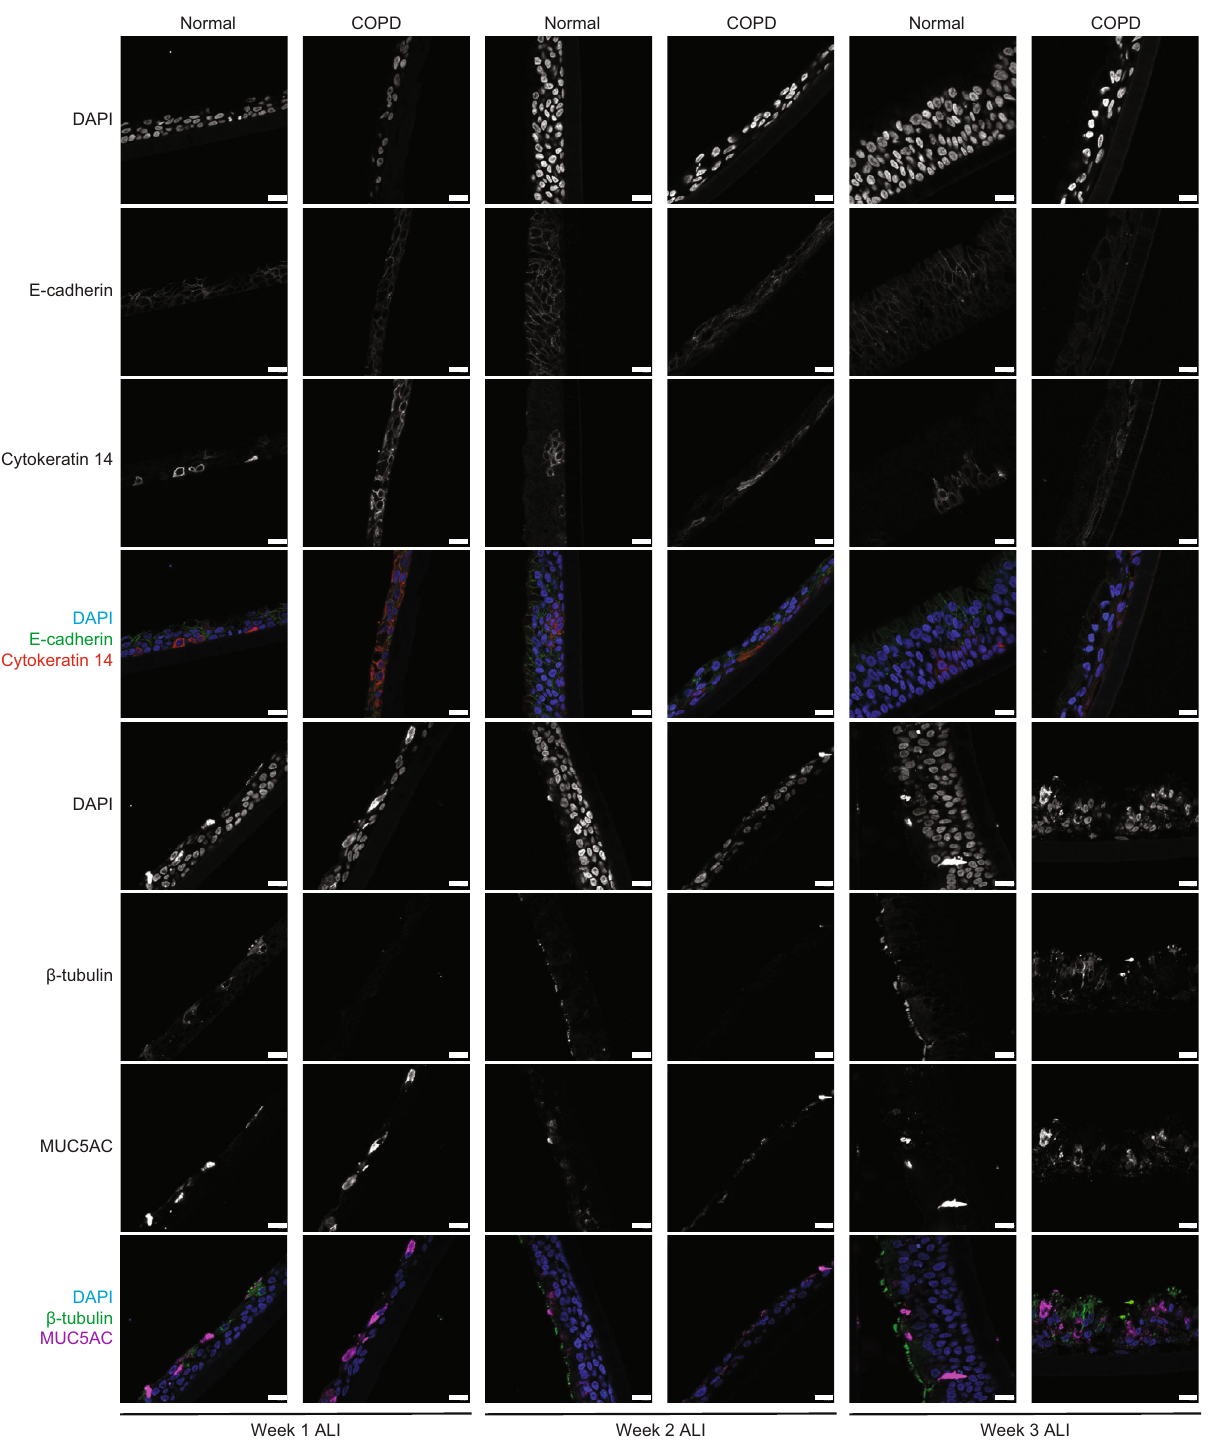
Fig. 4 Knockdown of E-cadherin decreases epithelial regeneration in human epithelial cells. Immuno fl uorescence at 40× (scale bar of 50 µ m) of COPD human bronchial epithelial cells differentiated at week one to three of air – liquid interface (ALI) show decreased expression of E-cadherin and β -tubulin (ciliated cells marker) expression, increase expression of MUC5AC (goblet cell marker), without any changes in Cytokeratin 14 (Basal cell marker), as compared to non-diseased human bronchial epithelial (normal)